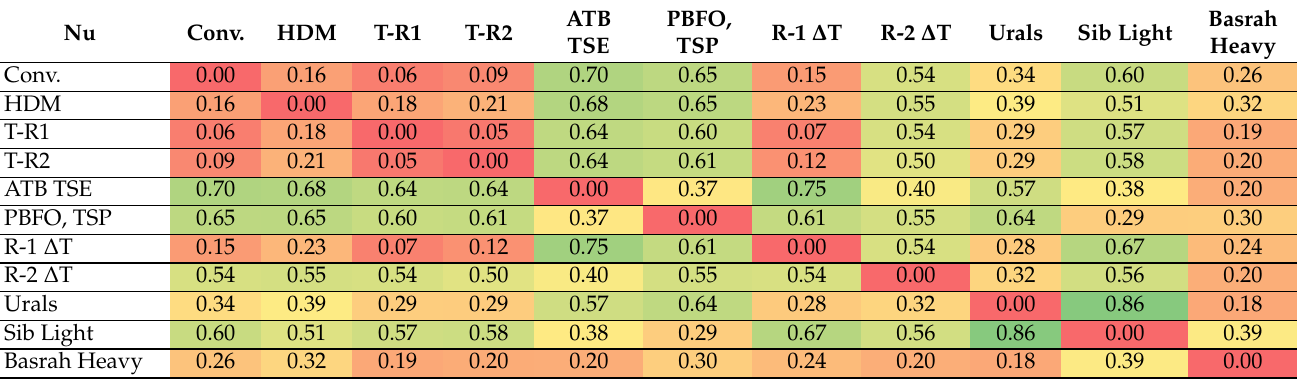
Table 4. µ -value of the ICrA evaluation of relations between the different variables characterizing hydrocracker